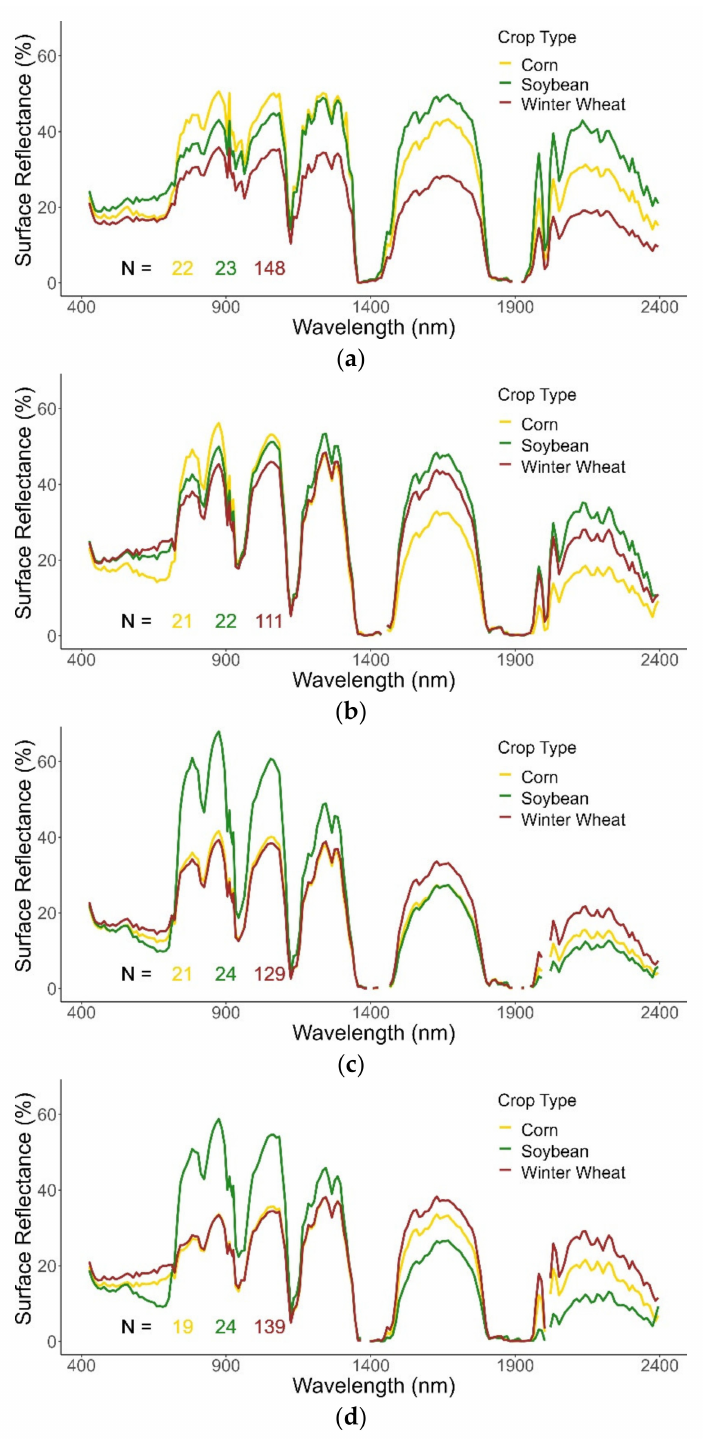
Figure 5. Average Hyperion 2013 (dry year) spectra by crop type for: ( a ) June (Julian Day 162), ( b ) July (Julian Day 191), ( c ) August (Julian Day 236), and ( d ) September (Julian Day 252). N is number of spectra included in the